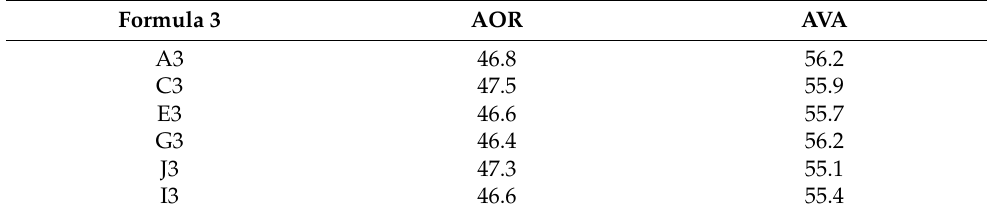
Table 9. The flow ability of powders prepared by Formula 3.